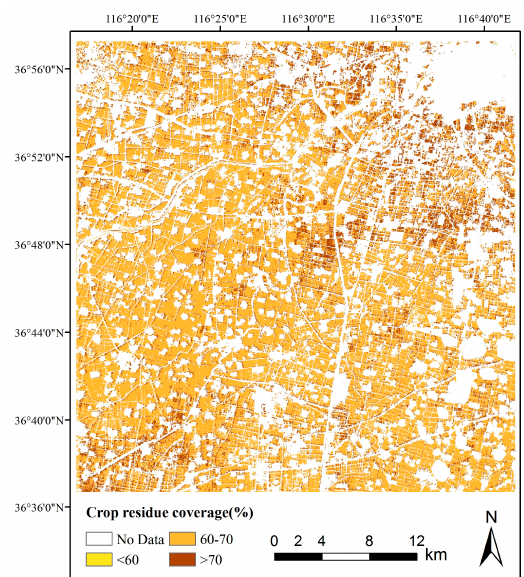
Figure 8. Predicted CRC map in study area on June 14, 2018.